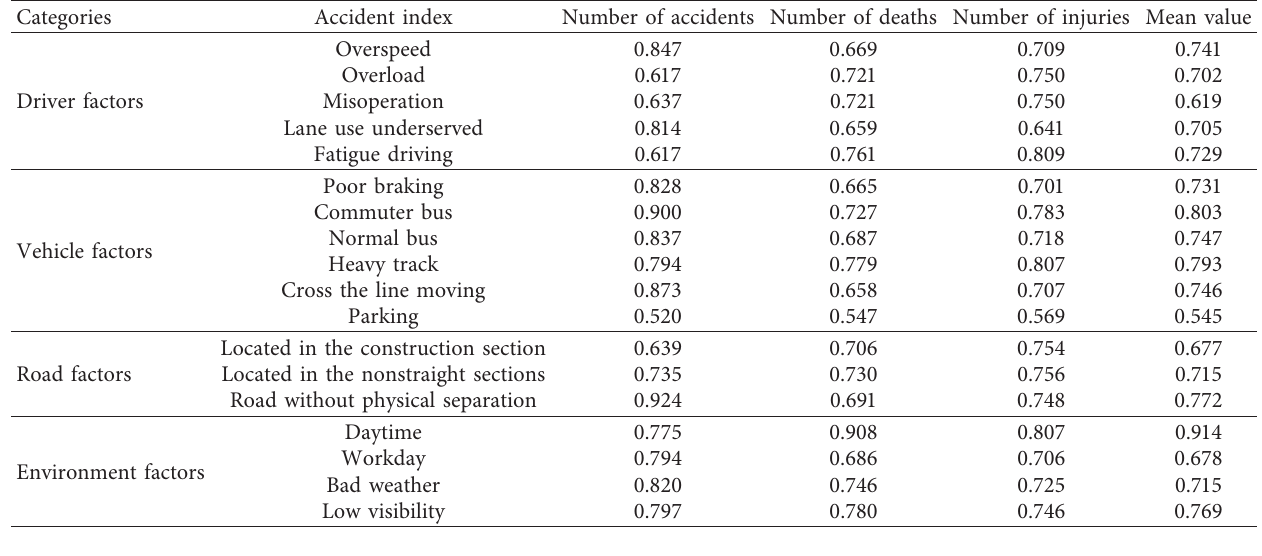
Table 5: The weighted grey correlation degree of multivehicle traffic accidents’ factors.